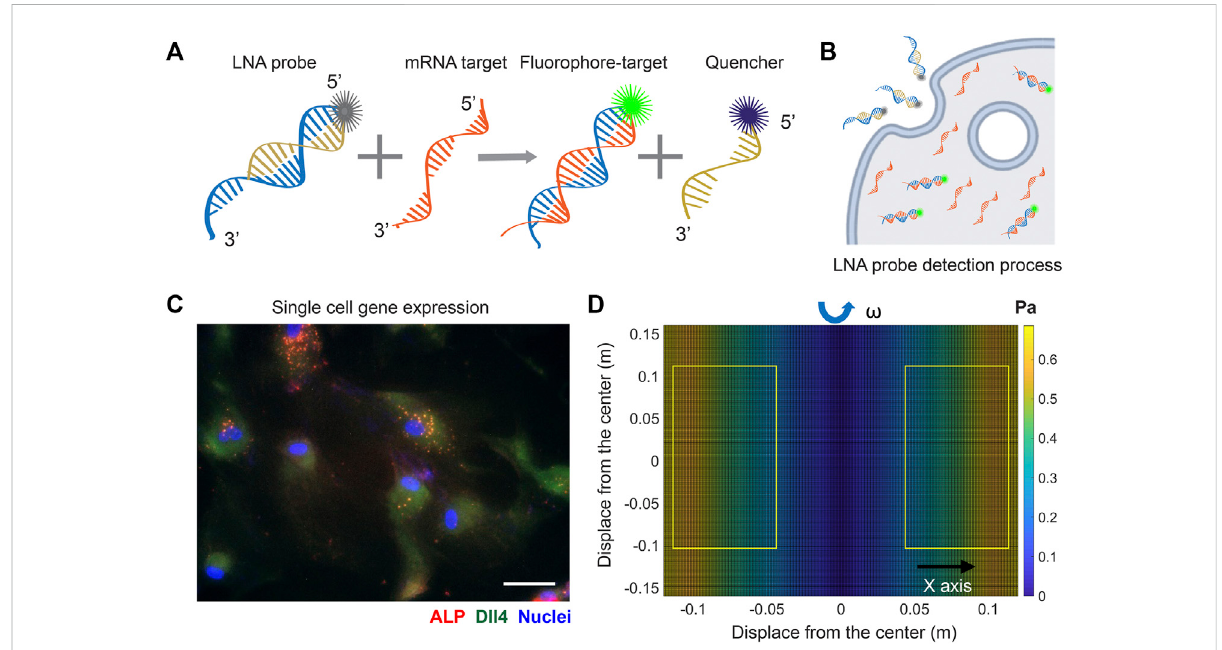
FIGURE 1 LNA/DNA nanobiosensor for single cell gene expression analysis in living cells. (A) Schematic illustration of LNA/DNA nanobiosensor for mRNA detection. Brie fl y, the LNA/DNA nanobiosensor is a complex of LNA donor and quencher probe. The fl uorophore at the 5 ′ of LNA donor probe is quenched due to close proximity. In the presence of target mRNA sequence,the LNA donor sequence is displaced from the quencher to bind to the target sequence, allowing the fl uorophore to fl uorescence. (B) Schematic illustration of cellular endocytic uptake of LNA/DNA nanobiosensor by cells for intracellular gene detection. (C) Representative fl uorescence image of Dll4 mRNA expression, ALP expression in hMSCs using LNA/DNA nanobiosensor. Green: Dll4 mRNA; red: ALP; blue: Nuclei. Scale bar: 100 μ m. (D) Simulated distribution of orbital shear stress. Yellow labeled rectangles indicate the location of well-plates. The estimated shear stress were in the range of 0.3 – 0.6